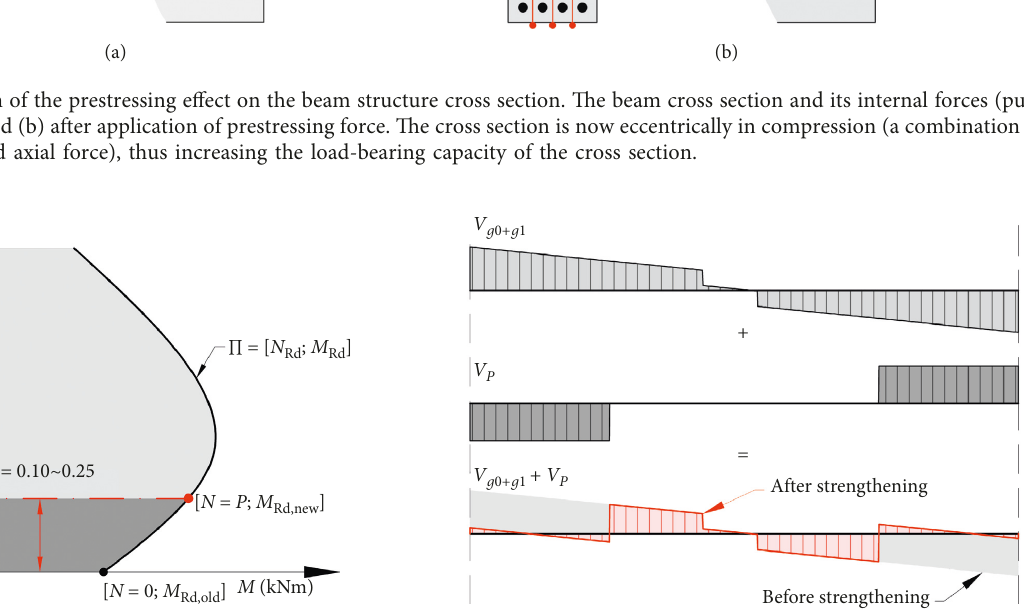
Figure 14: The basic scheme of reduction of shear forces due to the radial effects of prestressing cables in polygonal trajectory in the case of strengthening the simply supported beam according to Figure 11.